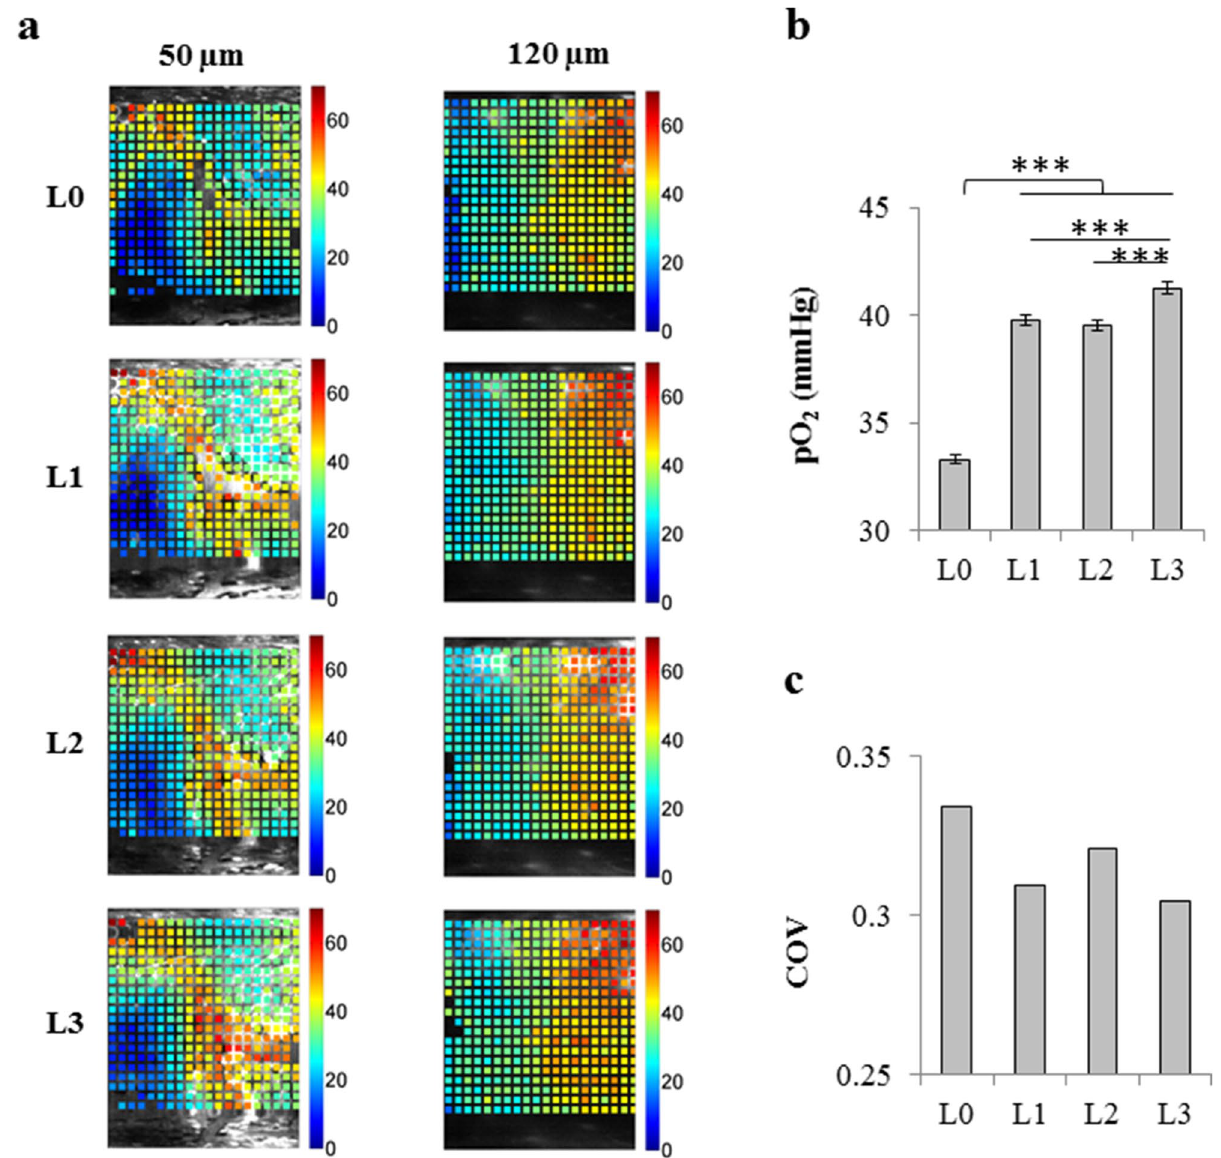
Figure 4. Cerebral tissue oxygenation. (a) Representative pO 2 grids over 400 μm × 400 μm regions at the depth of 50 μm (left) or 120 μm (right) at different exercise levels (L0 to L3). Color bars show tissue pO 2 in mmHg. (b) Average tissue pO 2 at exercise levels L0 to L3. (L0, n = 3,089; L1, n = 2,838; L2, n = 3,002; L3, n = 2,431 sampled points). The bars represent mean ± s.e.m. Statistical significance was calculated using ANOVA followed by Tukey HSD post hoc test. ***p < 0.001. (c) Spatial heterogeneity of pO 2 distribution in tissue (defined as coefficient of variation = SD/mean) for exercise levels L0 to L3. L0: rest, L1: exercise level 1 (5 m/min), L2: exercise level 2 (10 m/min), L3: exercise level 3 (15